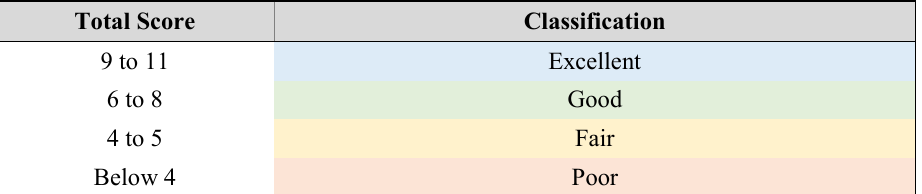
Figure 2. Classification of studies based on the total score.